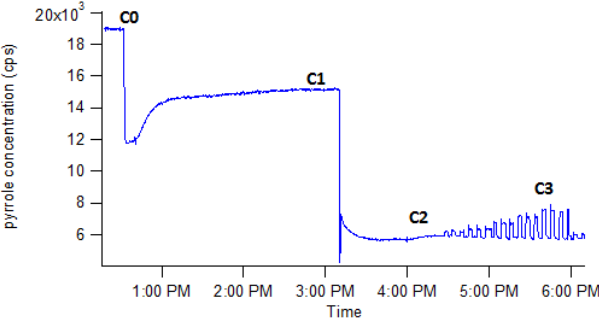
Figure 1. Pyrrole concentration detected by the PTR-MS during a typical OH reactivity experiment with CRM. C0, C1, C2, C3 are concentrations corresponding to different experimental stages. Technical improvements were done to minimize the difference be- tween C0 and C1 reducing pyrrole loss for